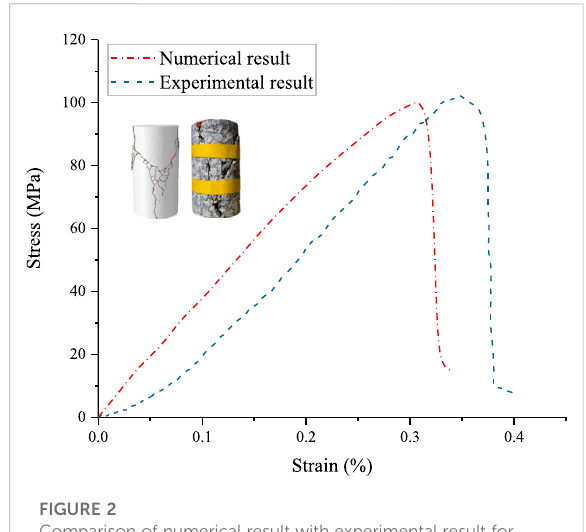
FIGURE 2 Comparison of numerical result with experimental result for the axial stress-strain curves of the granite